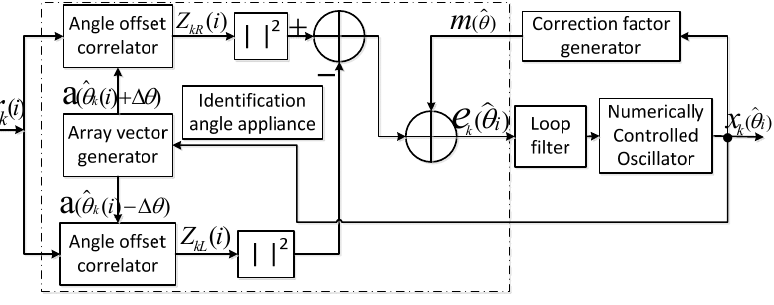
Figure 3. Tracking device in the Direction Lock Loop